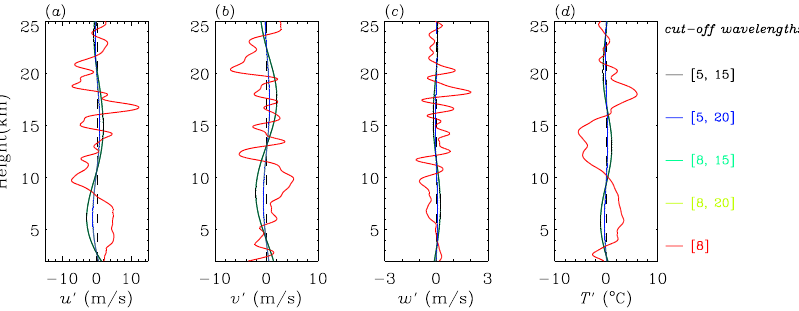
Figure 1. An example of gravity wave perturbations in zonal wind (a) , meridional wind (b) , vertical fluctuation (c) and temperature (d) profiles extracted from the radiosonde sounding launched at 08:00LT on 20 January 1998 at a middle-latitude station, Miramar Nas (32.87 ◦ N, 117.15 ◦ W), CA. Curves in red denote the perturbations extracted by low-pass filter with cut-off wavelength of 8km. Curves in the other colors denote the differences of the perturbations. These differences are obtained by subtracting the results extracted by the low-pass filter from those extracted by band-pass filters with different cut-off wavelengths, which are, respectively, 8 and 20km, 8 and 15km, 5 and 20km and 5 and